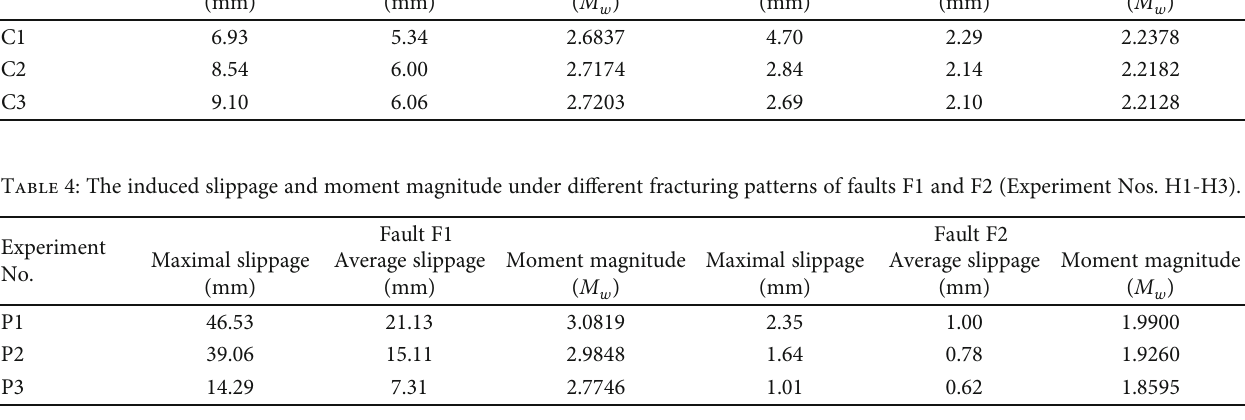
Table 3: The induced slippage and moment magnitude under di ff erent fracturing patterns of fault F1 and F2 (Experiment Nos. C1-C3). Experiment